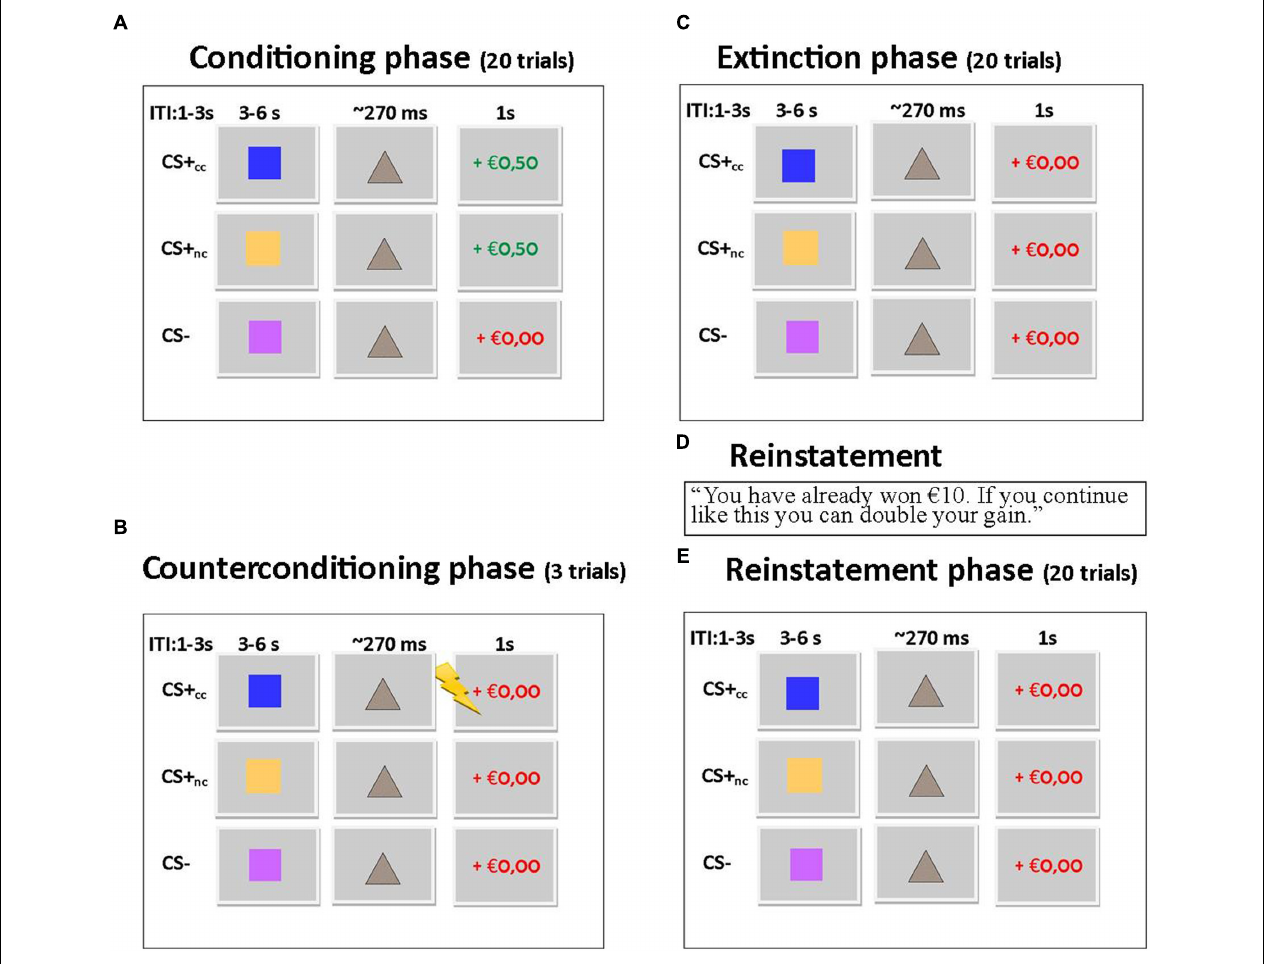
FIGURE 1 | (A) Trial sequence for conditioning phase. 50% of the CS + trials were reinforced with a monetary gain. Each stimulus is presented 20 times. (B) Trial sequence for counterconditioning phase. The CS + cc stimuli are reinforced with an electrical shock, the other stimuli are not reinforced. Each stimulus is presented three times. (C) Trial sequence for extinction phase. None of the stimuli is reinforced. Each stimulus is presented 20 times. (D) Reward is reinstated by showing this text. (E) The trial sequence for the reinstatement phase is similar to the trial sequence of the extinction phase. Each stimulus is presented 20